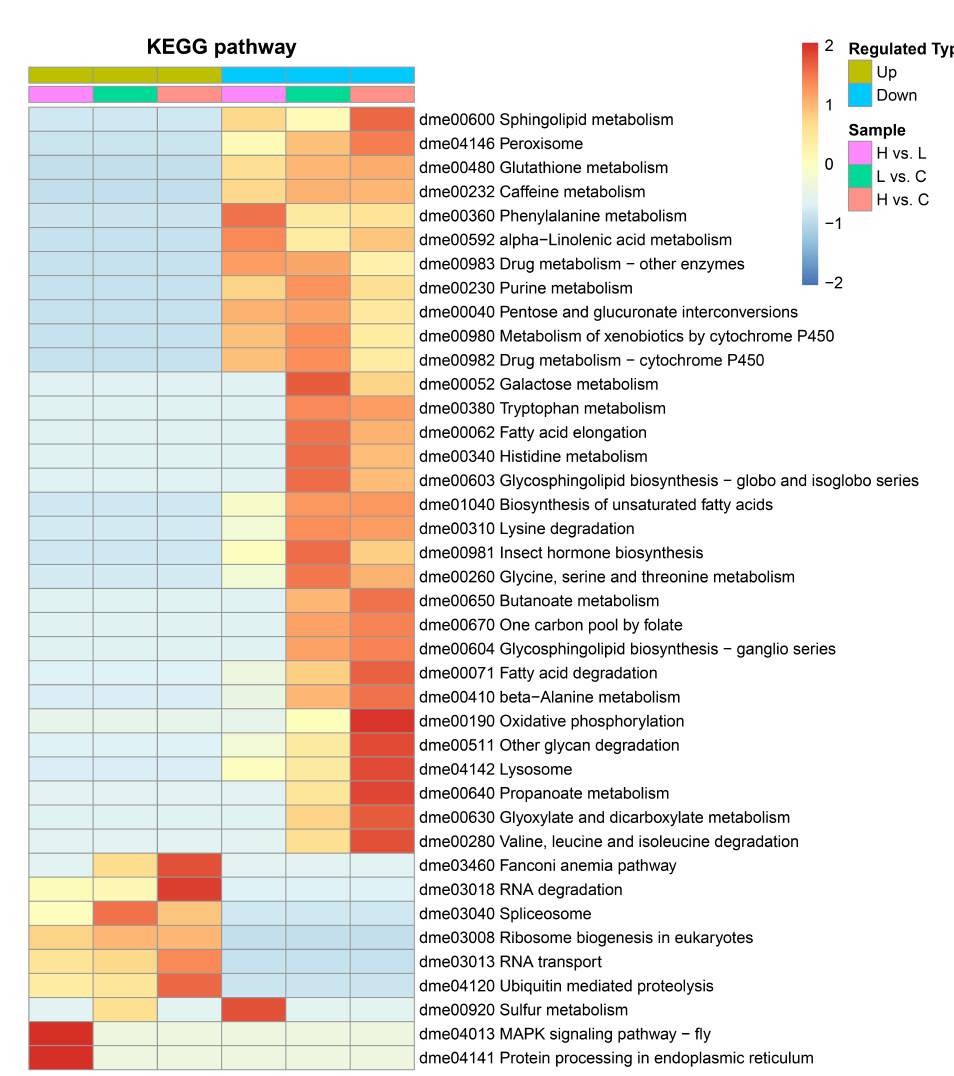
Figure 3. Functional enrichment clusters of differentially expressed proteins. KEGG enrichment of differentially expressed proteins. One color block represents a functional pathway of DEPs enrichment in different comparison groups, red represents a high degree of enrichment, and blue represents weak enrichment. The entire enriched KEGG pathways mainly manifested as down-regulated lipid and amino acid metabolism, and the regulation level between the H and L groups was